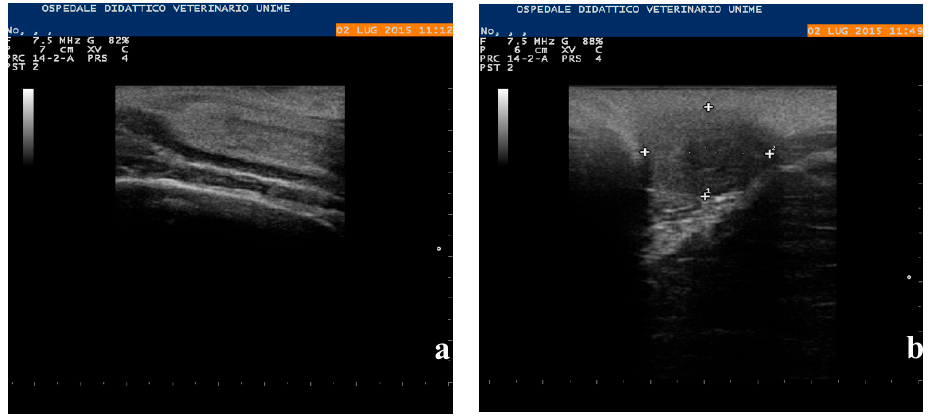
Figure 3. Ultrasound exam. ( a ) Cervix in the floor of the pelvis, with dimensions of 3.5 × 1.5 cm; ( b ) uterine horn and gonad of ovoid shape and 1.8 × 2.3 cm size.